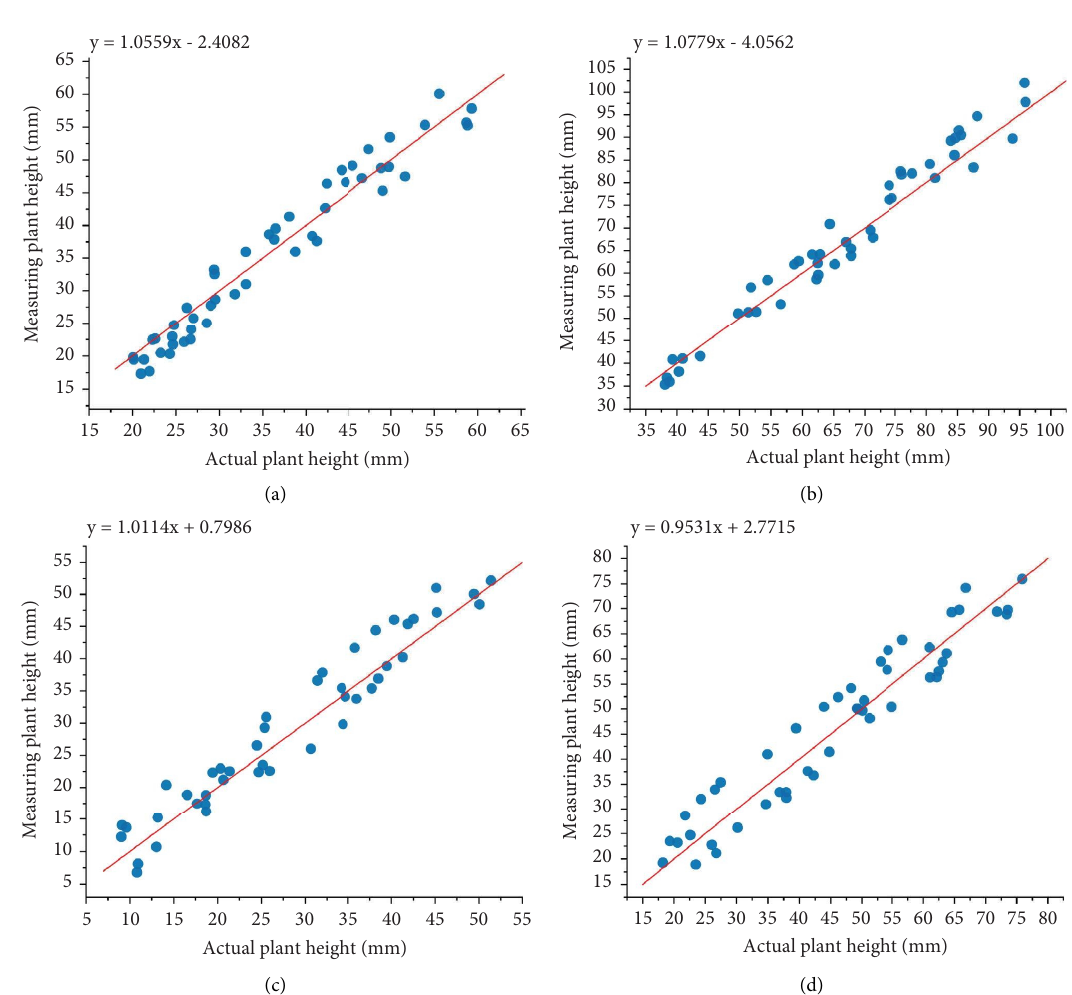
Figure 18: Scatter plot of actual seedling heights and measured seedling heights. (a) Watermelon seedling data at the young seedling stage. (b) Watermelon seedling data at the one-true leaf and one-apical bud stage. (c) Pumpkin seedling data at one-true leaf and one-apical bud stage. (d) Pumpkin seedling data at the two-true leaf and one-apical bud